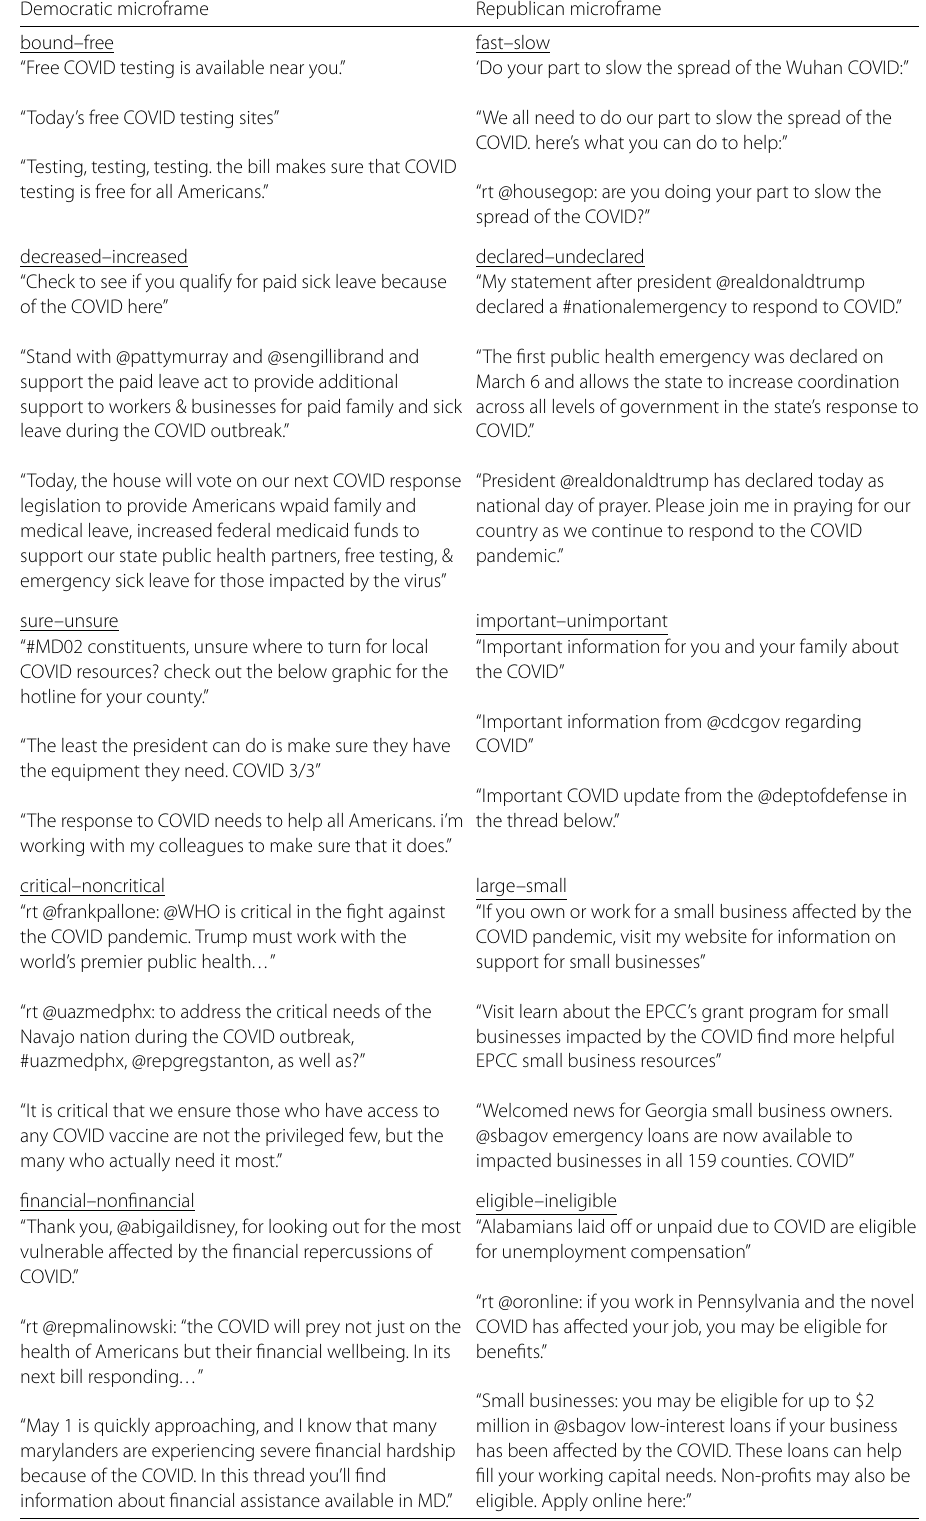
Table 3 Three top tweets from each microframe with the largest difference in intensity between two parties. URLs, emojis, and some special characters are omitted Democratic microframe Republican microframe bound–free fast–slow “Free COVID testing is available near you.” “Today’s free COVID testing